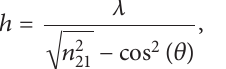
gas in FTIR 2 −1 and 1480–1450cm